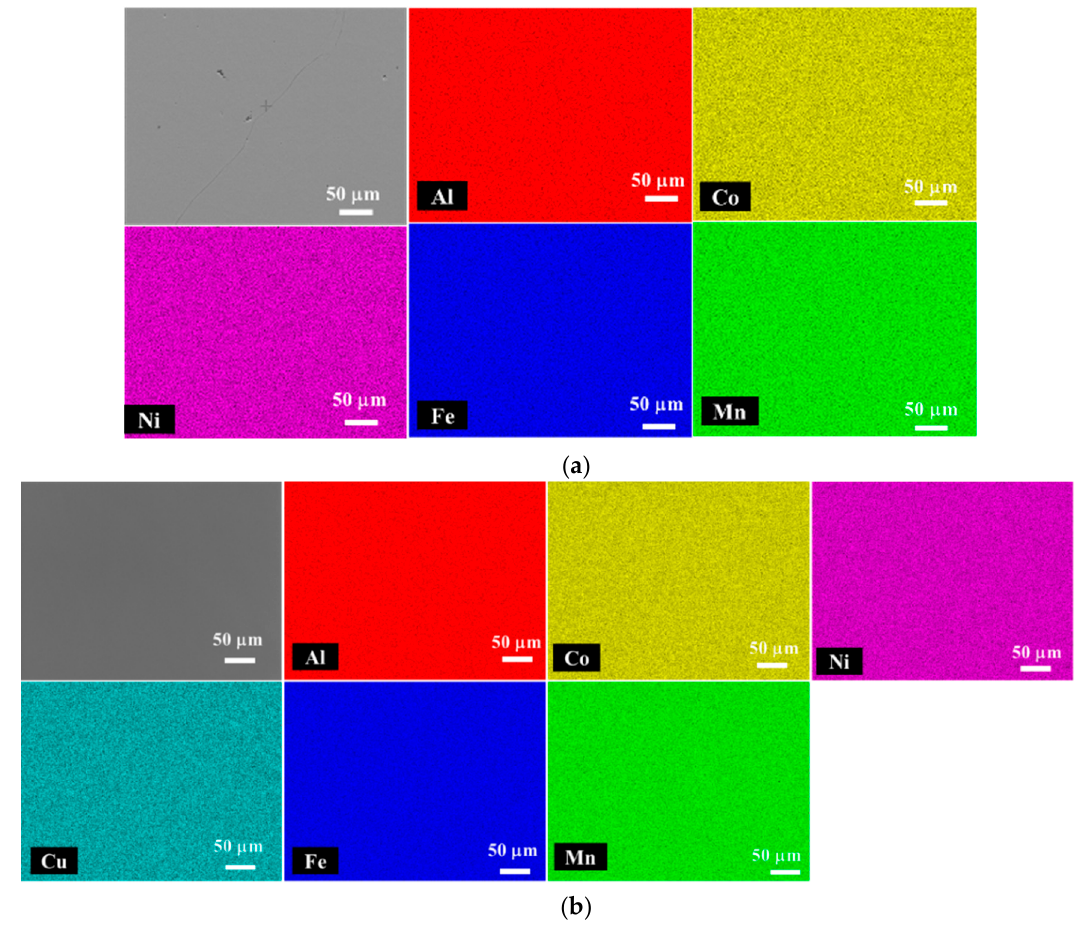
Figure 9. SEM-BSE image and elemental mapping of the ( a ) Al(CoFeMnNi) and ( b ) Al(CoCuFeMnNi) multicomponent alloys homogenized at 1373 K for 144 h.